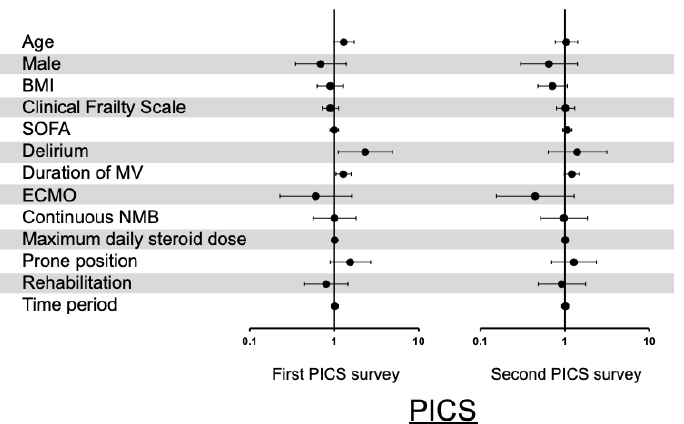
Figure 4. Risk factors for post-intensive care syndrome (PICS). Results of multiple logistic regression analysis of PICS are shown in a forest plot. Age was calculated in increments of 10 years, body mass index in increments of 5 kg/m 2 , mechanical ventilation period in increments of 7 days, and steroid dose in increments of 50 mg/day. Time period refers to the period from ICU survival discharge to